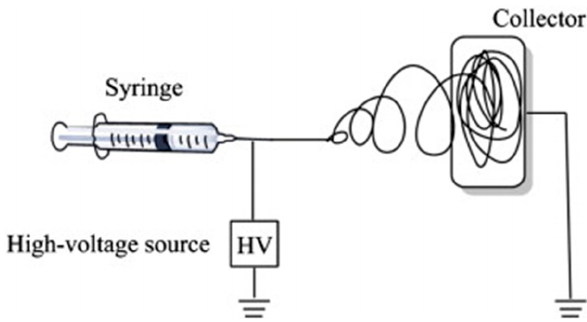
Figure 1. Schematic illustration of the basic setup for electrospinning. Reproduced from [62] with permission. Copyright (2015) Elsevier. permission. Copyright (2015)